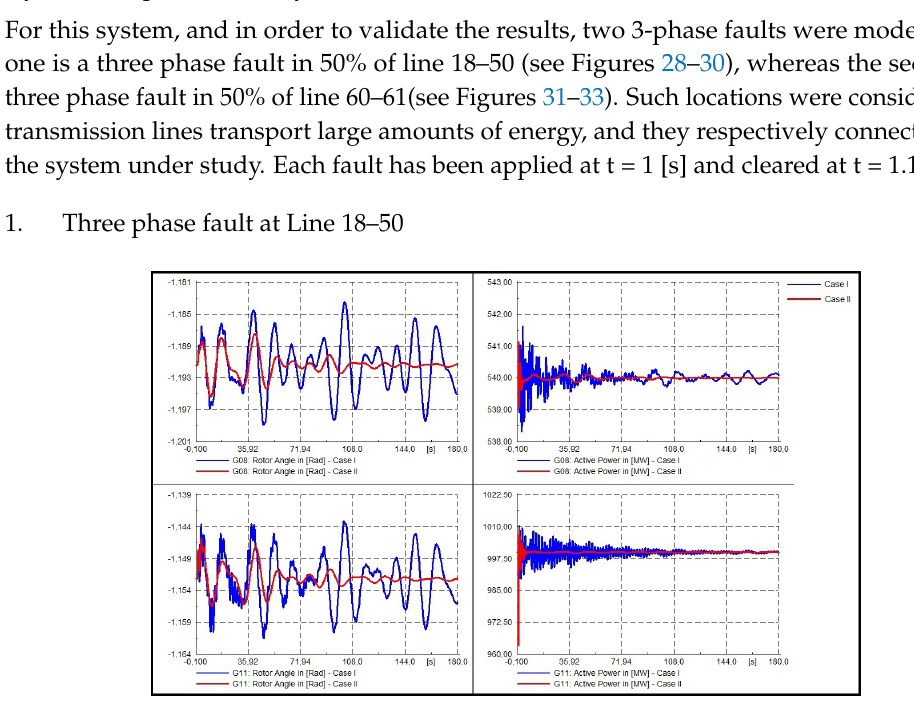
Figure 28. Rotor angle [rad] and Active Power [MW]-three phase fault at Line